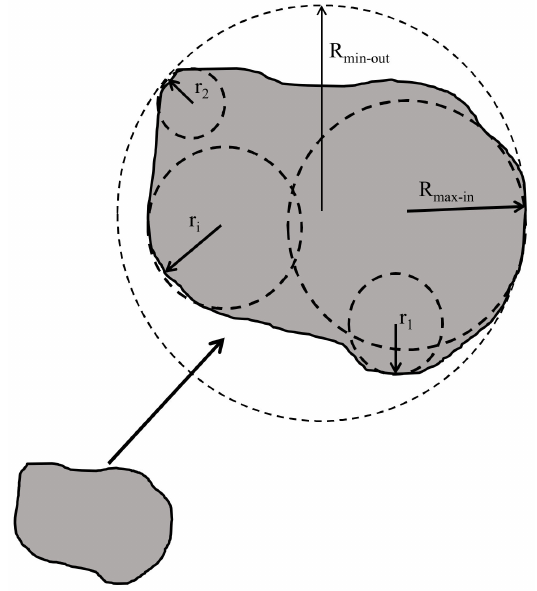
Figure 3. Particle shape parameters used in defining roundness [50,51].